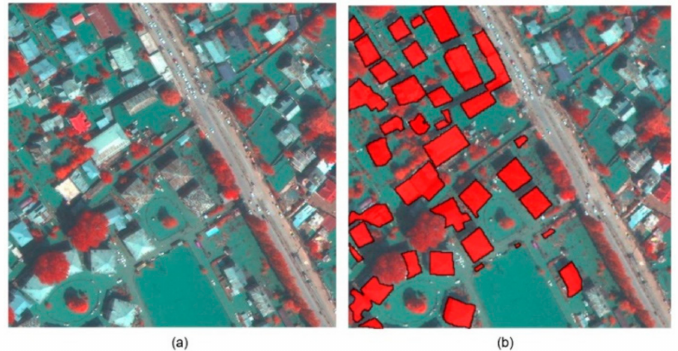
Figure 13. ( a ) Remote sensing scene captured during an urban flood. ( b ) Spatio-Contextual Triple Aggregate in the scene formed by aggregating spatial and contextual semantics—buildings (triples) that are flooded (contextual) and are to the West direction (spatial) of the road that is unaffected (contextual) by the